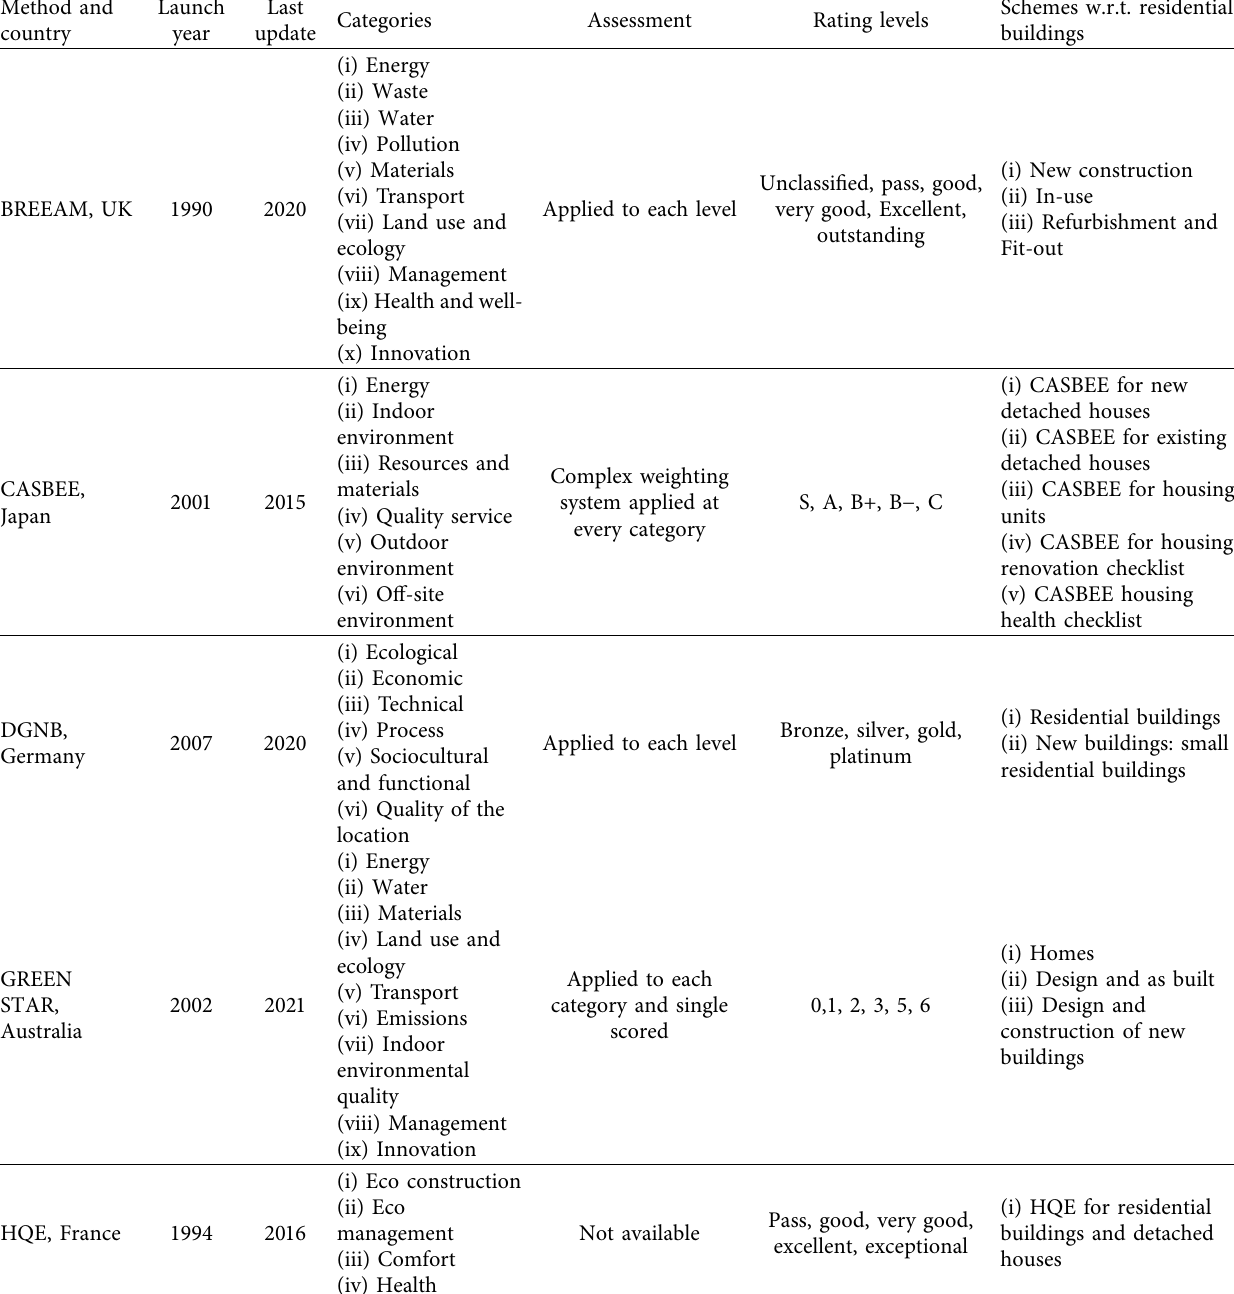
Table 3: Main features of selected building environment assessment methods